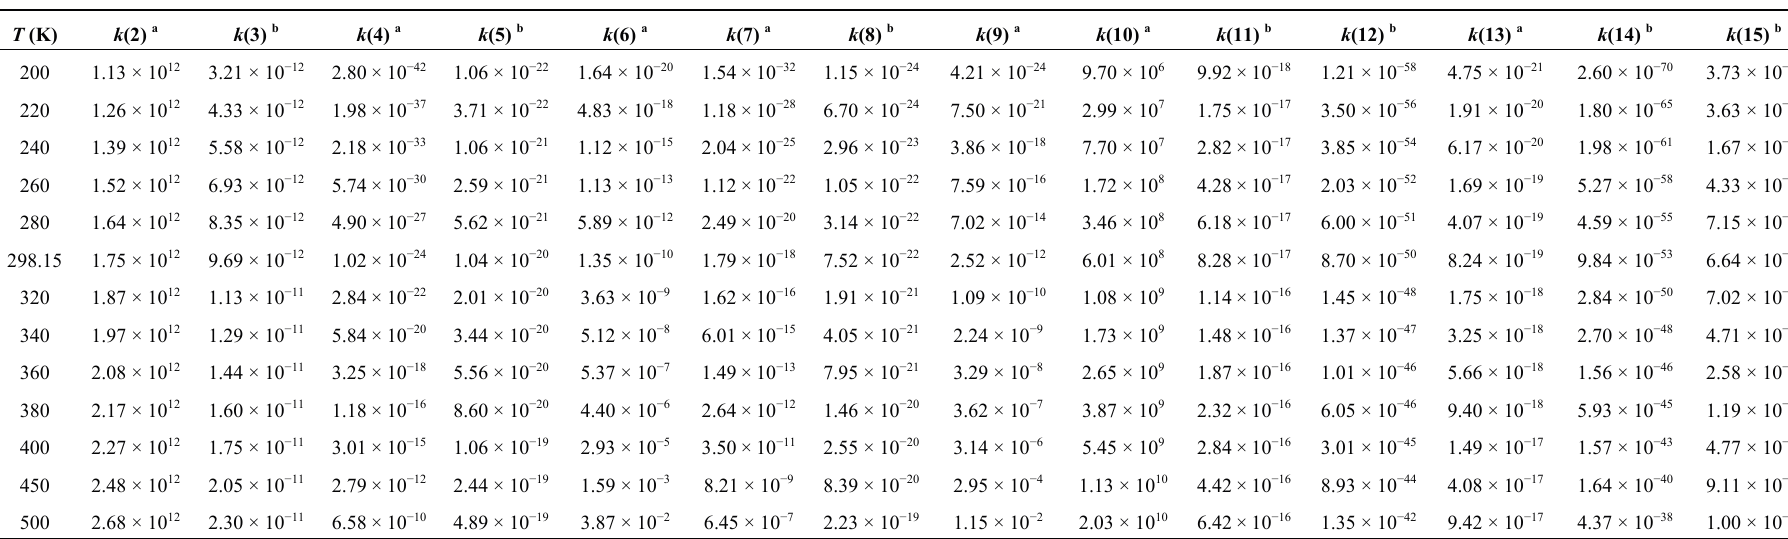
Table 2. The rate constants of elementary reactions (2)–(15) at the temperature range of 200–500 K